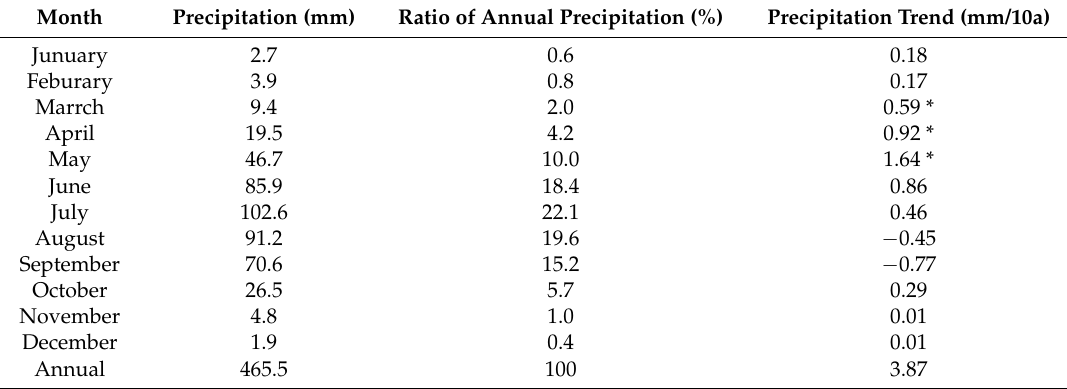
Table 2. The precipitation amount and trends in each month on the TP during